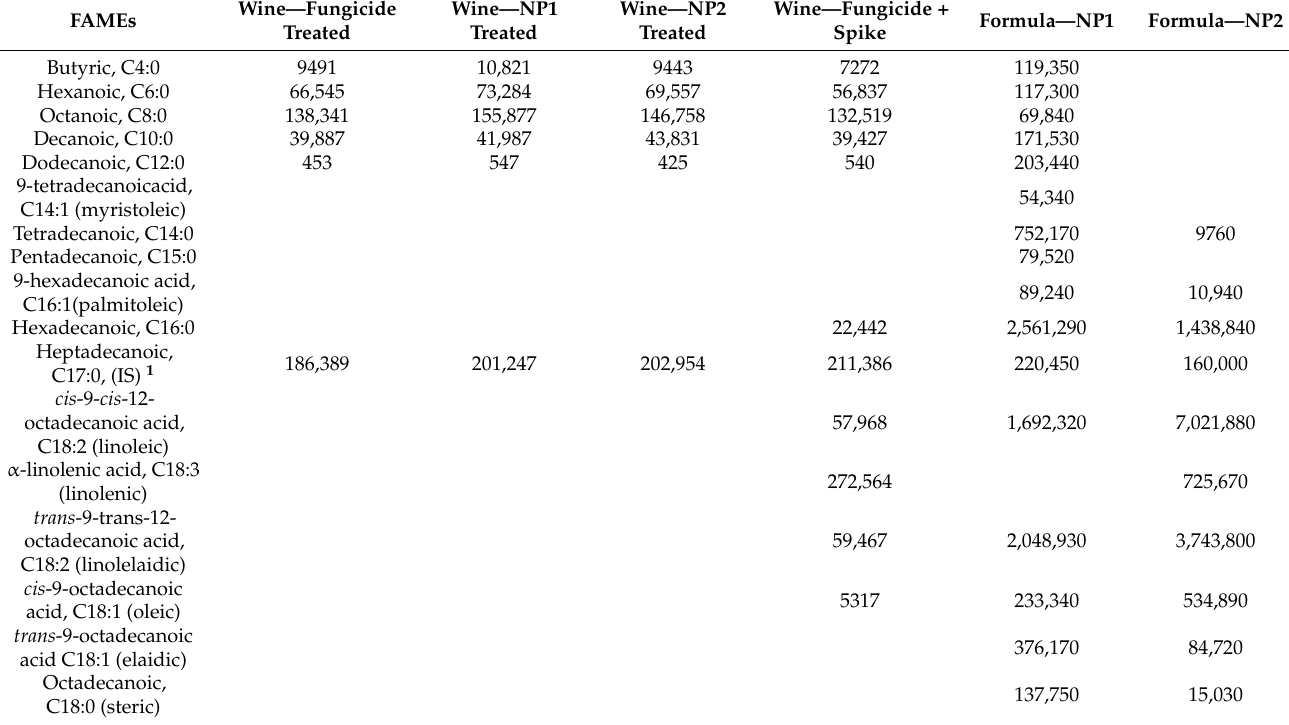
Table 2. Peak area response of fatty acid methyl esters (FAMEs) identified in Natural Product (NP) formulations (Formula) and treated finished wine samples (Wine) from the Chardonnay Season 2 vintage from Hawke’s Bay. Flax seed oil was spiked into the control (fungicide) treatment wine to test for recovery of trans-esterified fatty